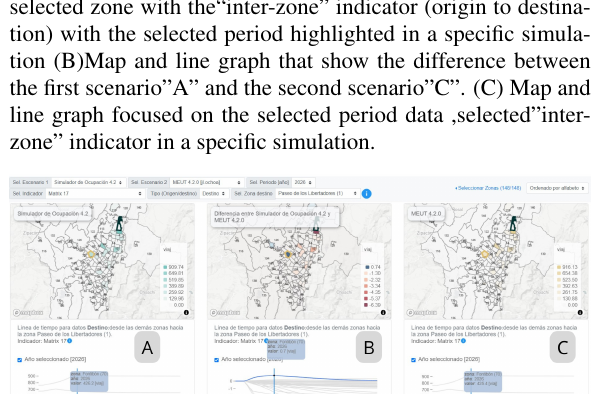
Figure 4. Inter-zone comparator explorer